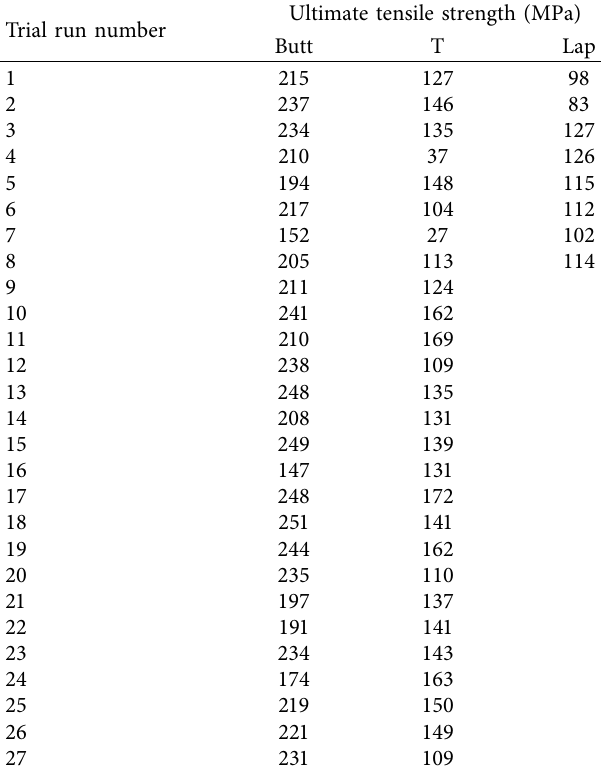
Table 2: The UTS of a material with different joints.